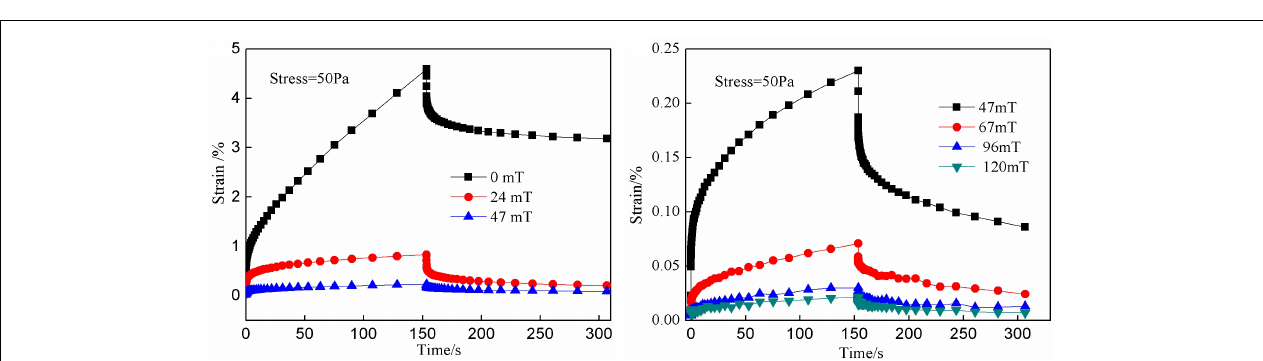
FIGURE 6 | Creep and recovery curves of MRG under different constant stress. (A) B = 0 mT; (B) B = 47 mT.